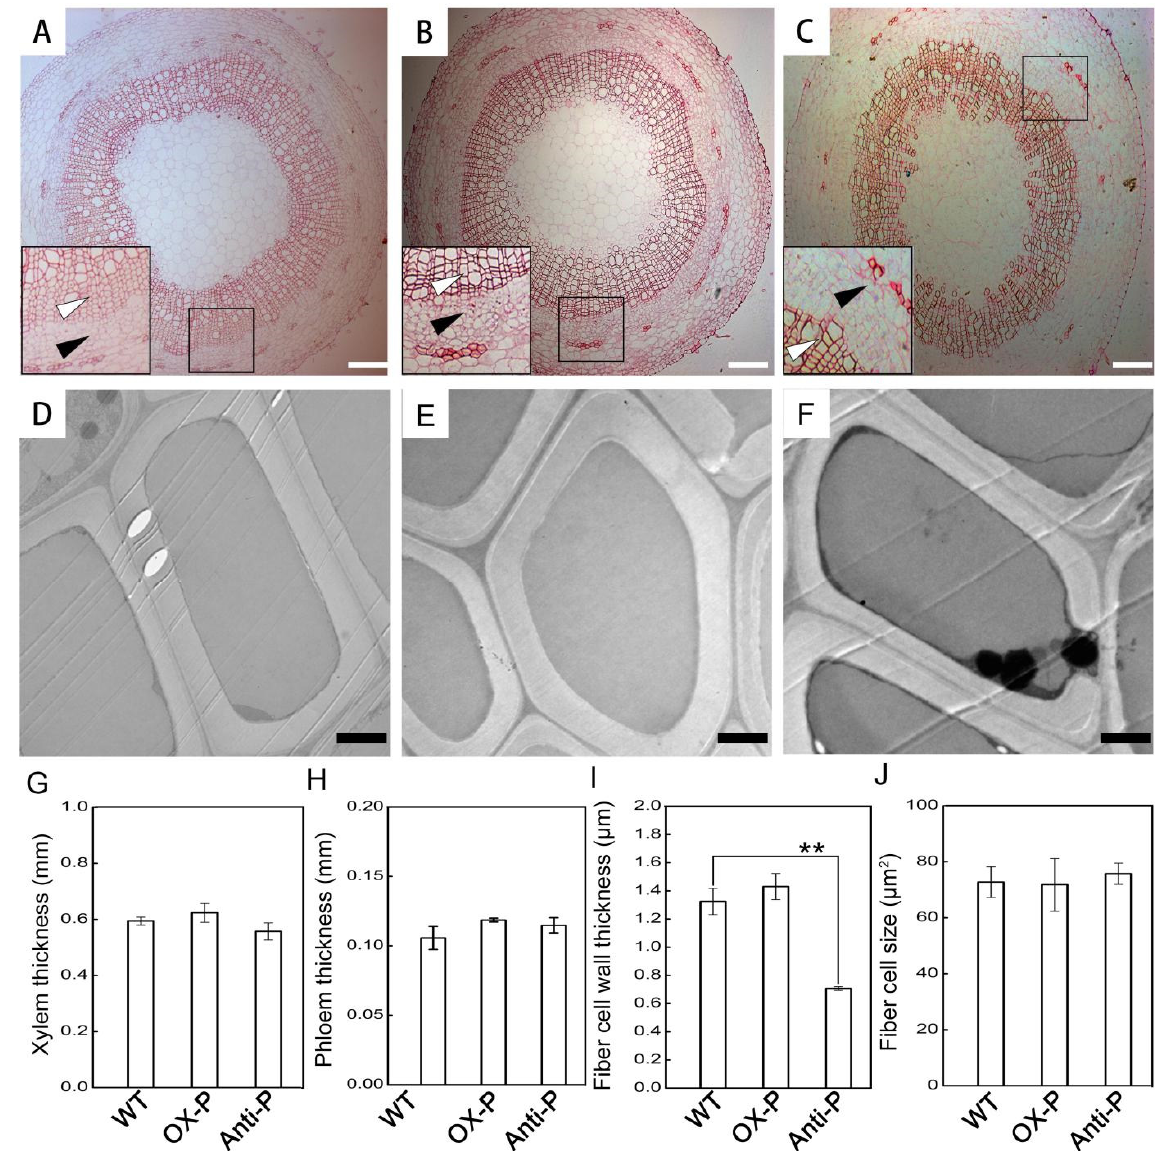
Figure 2. Changes in stems of transgenic plants of P. tomentosa . ( A – C ), Paraffin sections in 2-month old plants . ( A ), WT; ( B ), OX-P; ( C ), Anti-P. Bar = 200 μ m. ( D – F ), Transmission electron micrographs stem transverse sections in 2-month old plants . ( D ), WT; ( E ), OX-P; ( F ), anti-P. Bar = 2 μ m. ( G ), Xylem thickness in transgenic plants of WT, OX-P and anti-P during plant growth . Micrographs of sections from 3 specimens were examined. Statistical differences were determined. Values are means ± SD ( n = 3). ( H ), Phloem thickness in transgenic plants of WT, OX-P and anti-P during plant growth. Micrographs of sections from 3 specimens were examined. Statistical differences were determined. Values are means ± SD ( n = 3). White or black arrowheads mark the partially enlarged views of xylem or phloem in WT, OX-P and anti-P, respectively. ( I – J ), Fiber cell wall thickness or size in transgenic plants. Micrographs of sections from 3 specimens were examined. Statistical differences were determined. Values are means ± SD ( n = 60 or 30). Significant differences between mean values are indicated by asterisks using Student’s t -test. ** and * indicate p < 0.01 and p < 0.05,